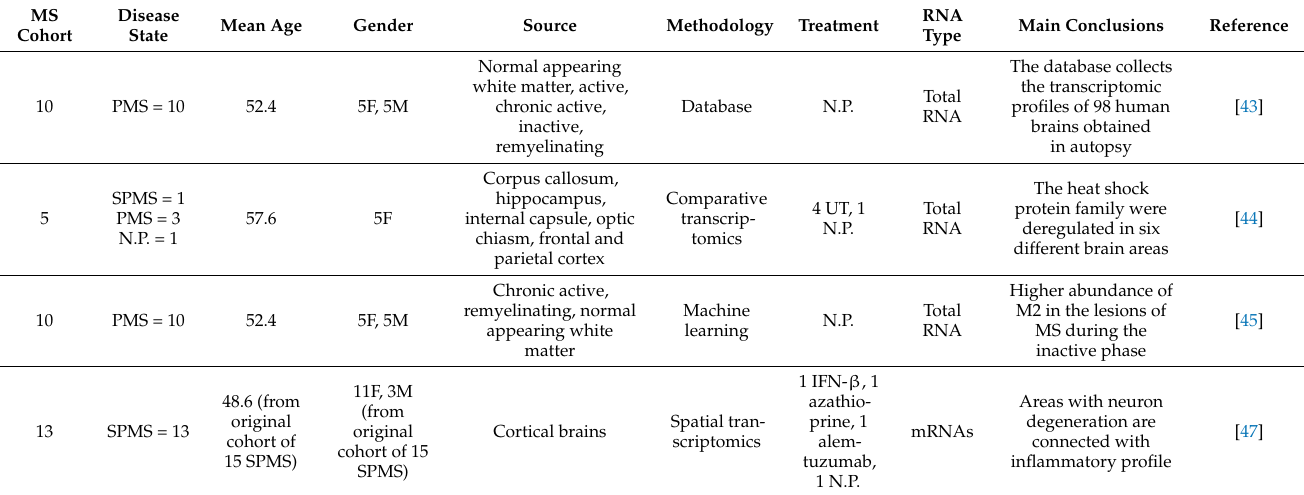
Table 4. Overview of the studies exploring transcriptomes in the human